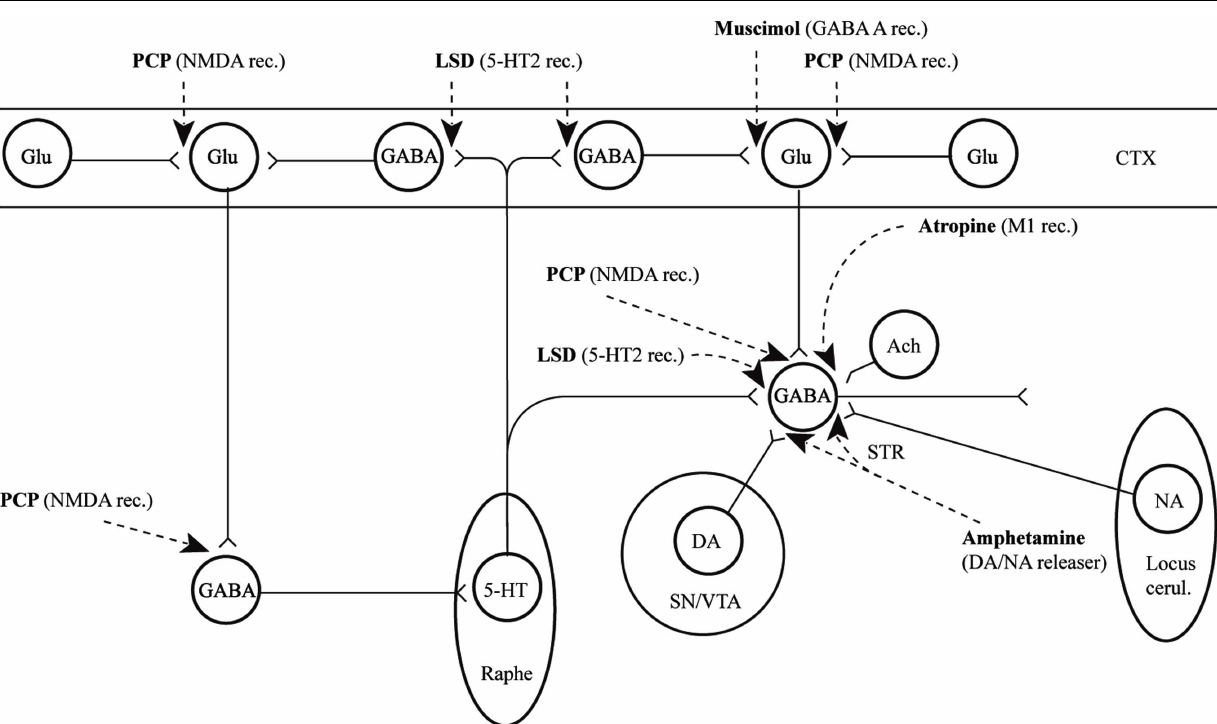
FIGURE 6 | Psychotogenic pathways vicious circle (left). Schematic diagram illustrating potential psychotogenic pathways and sites of action of psychotogenic and antipsychotic agents.The striatal complexes (STR, the centrally located circle) are composed of the dorsal and ventral striatum/pallidum.The striatum receives glutamatergic inputs from all parts of the cerebral cortex as well as serotonergic, dopaminergic, and noradrenergic inputs from the lower brainstem. Amphetamine and phencyclidine (PCP) are